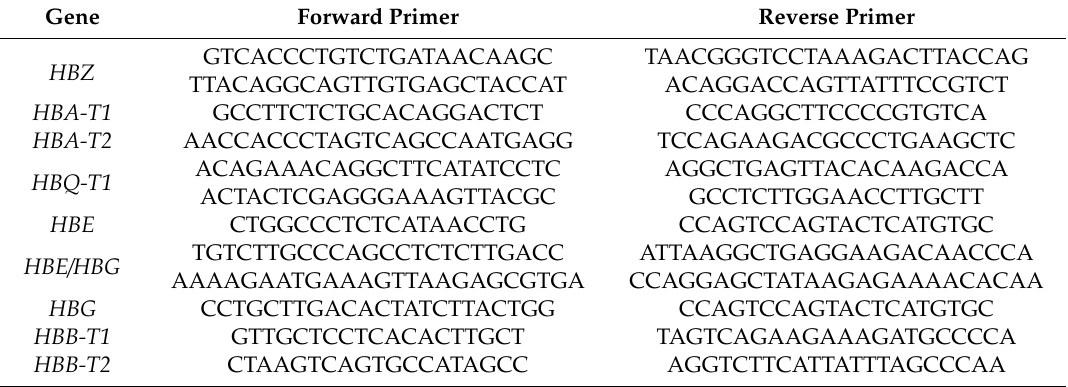
Table 4. Primers used for the amplification of Hb genes in the present study.